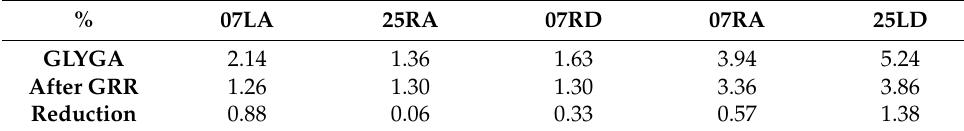
Table 1. Comparison of Alert Duration before and after application of